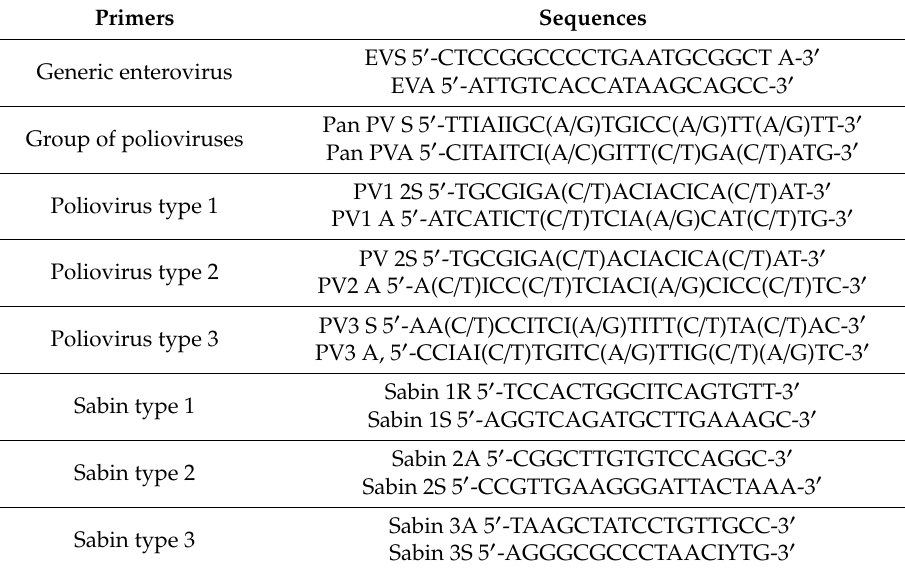
Table 2. Primers used for polymerase chain reaction (PCR) amplification and